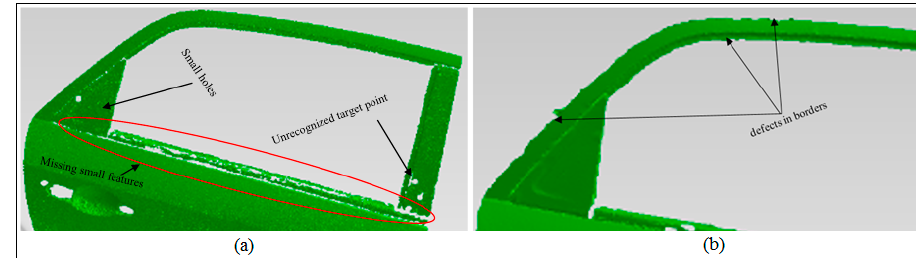
Figure 10. Defects in the data points of the white light scanner—( a ) missing data; ( b ) edge defects. The RMS value of deviations, scanning time, and triangle numbers at different combinations of scanning parameters can be seen in Table 3. Table 3. A sample data for Laser Scanner (ViuScan) and White Light Scanner (GoScan). Viu Scan Laser Power (%) Run No.